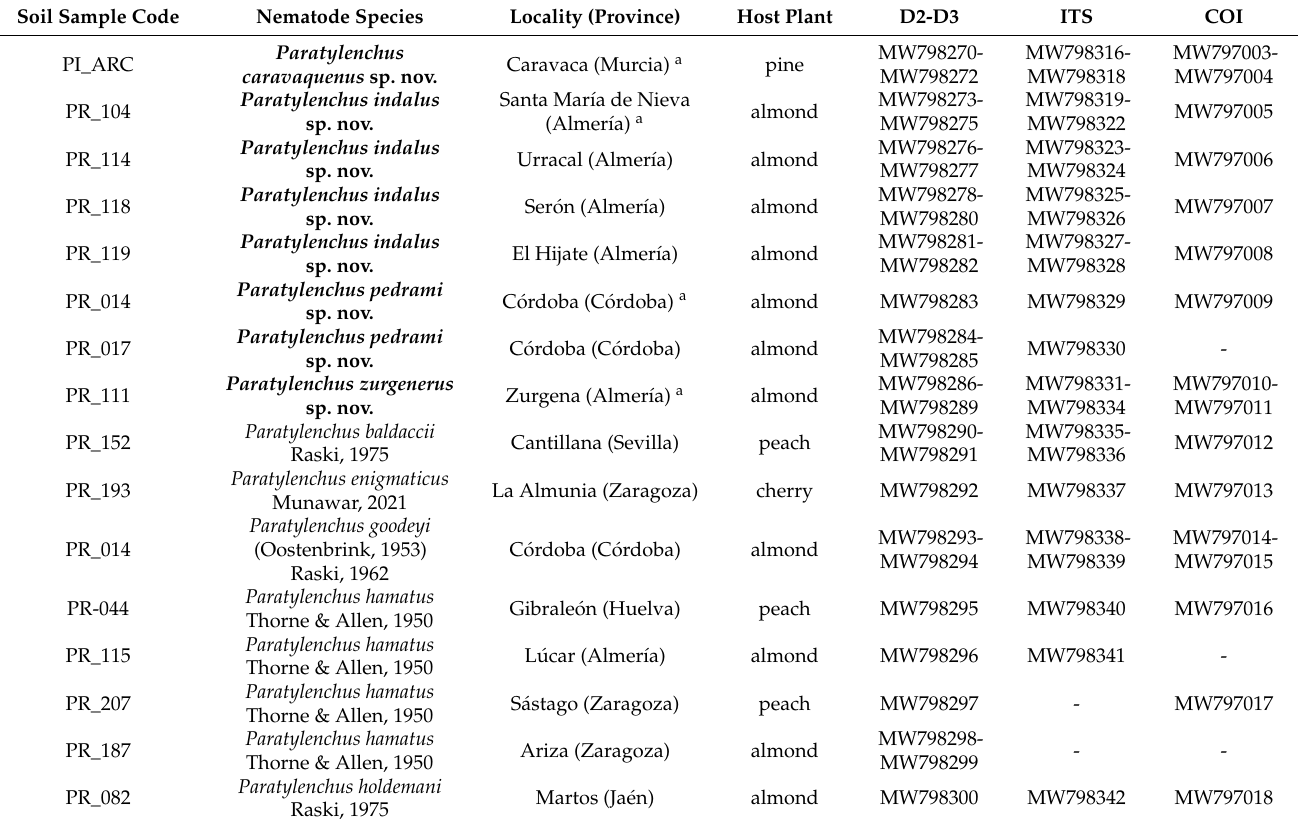
Table 1. Isolates sampled and sequenced for Paratylenchus spp. from several localities in Spain used in this study. Different rootstocks could be used in the cultivated plants. Soil Sample